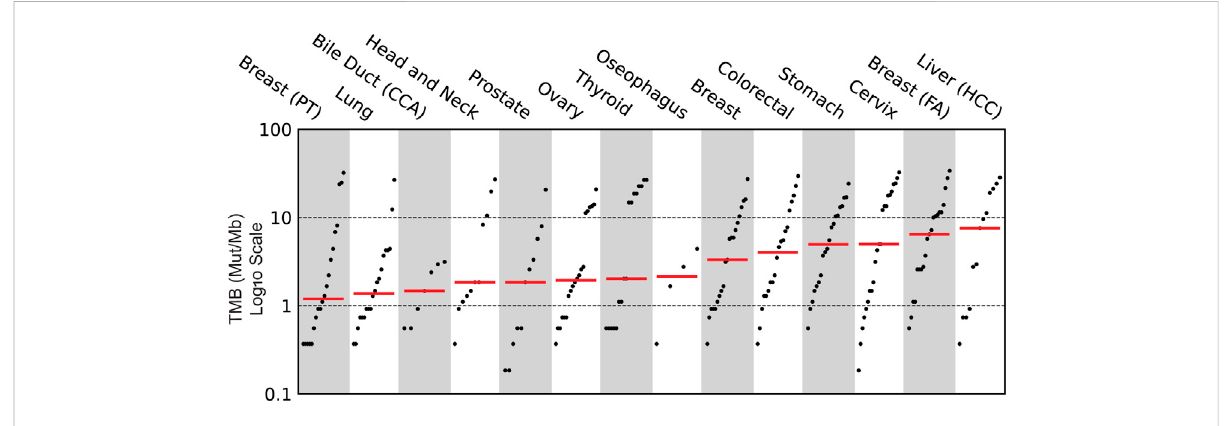
FIGURE 3 Clinical evaluation of Tumor Mutational Burden (TMB) across the various cancer subtypes pro fi led using Asian Pan-Cancer